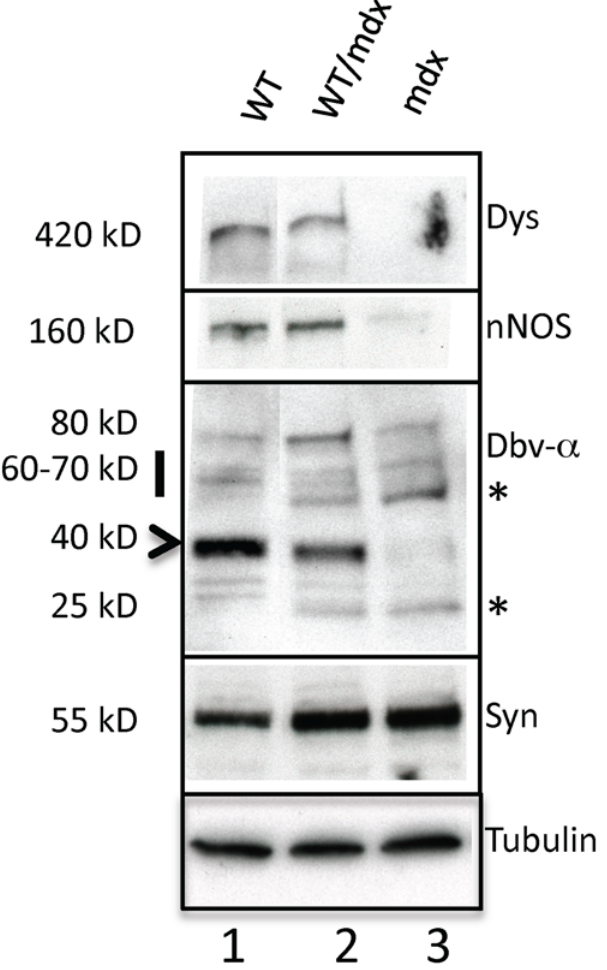
Figure 10. WT/mdx muscle displays nNOS and dystrobrevin- a . Protein extracts from diaphragms of WT (lane 1), 10–30% WT/mdx (lane 2) and mdx (lane 3) mice were subjected to a western blot for dystrophin, nNOS, dystrobrevin- a , syntrophin and tubulin. *: dystrobrevin- a isoforms enriched in mdx and WT/mdx but not in WT muscle. Experiments were performed with pectoralis, diaphragm and quadriceps muscles of 3 animals (n=3) per group (WT, 10–30% WT/mdx and mdx).